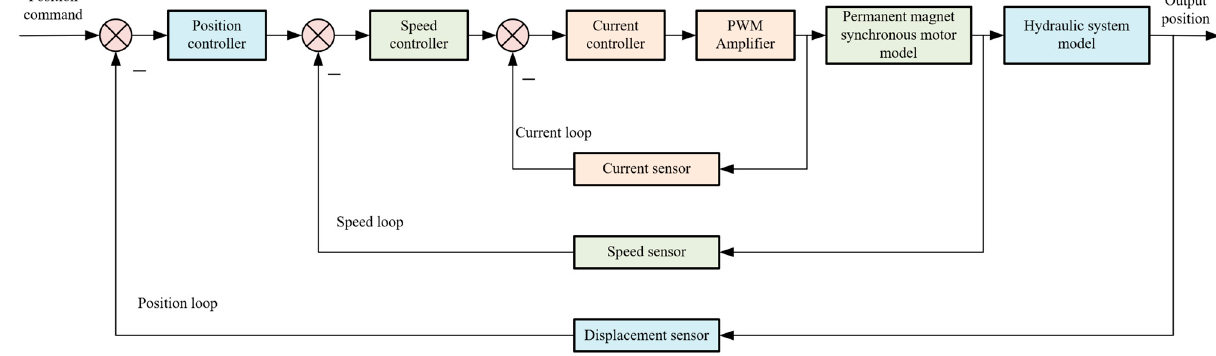
Figure 5. Simulation diagram of double redundancy EHA system.